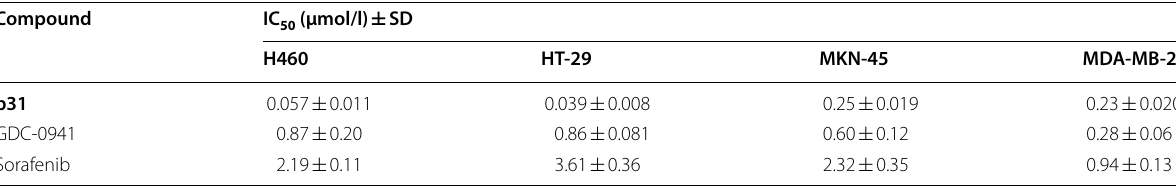
Table 27 Cytotoxicity of compound b31 Compound